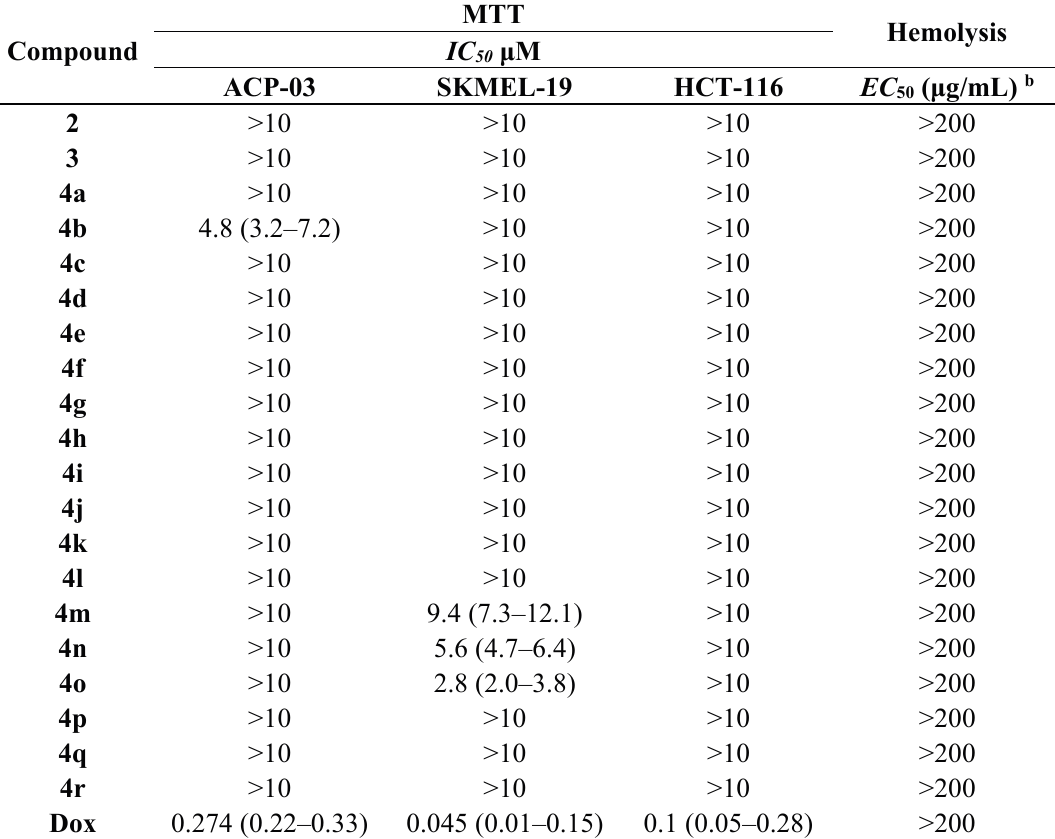
Table 1. Cytotoxic activity of 1,3-benzoxathiol-2-one derivatives for cancer cell lines a .